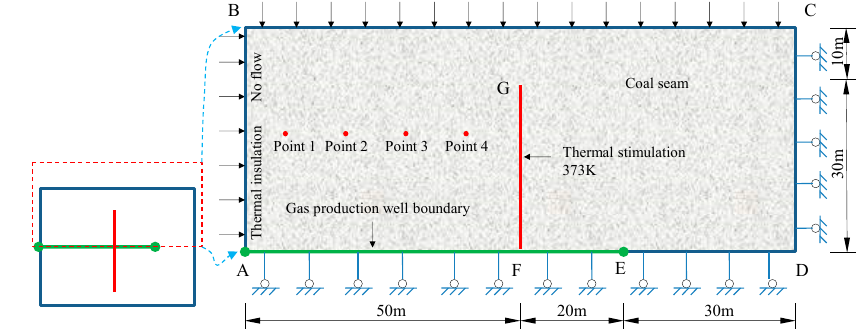
Figure 4. Numerical simulation model.